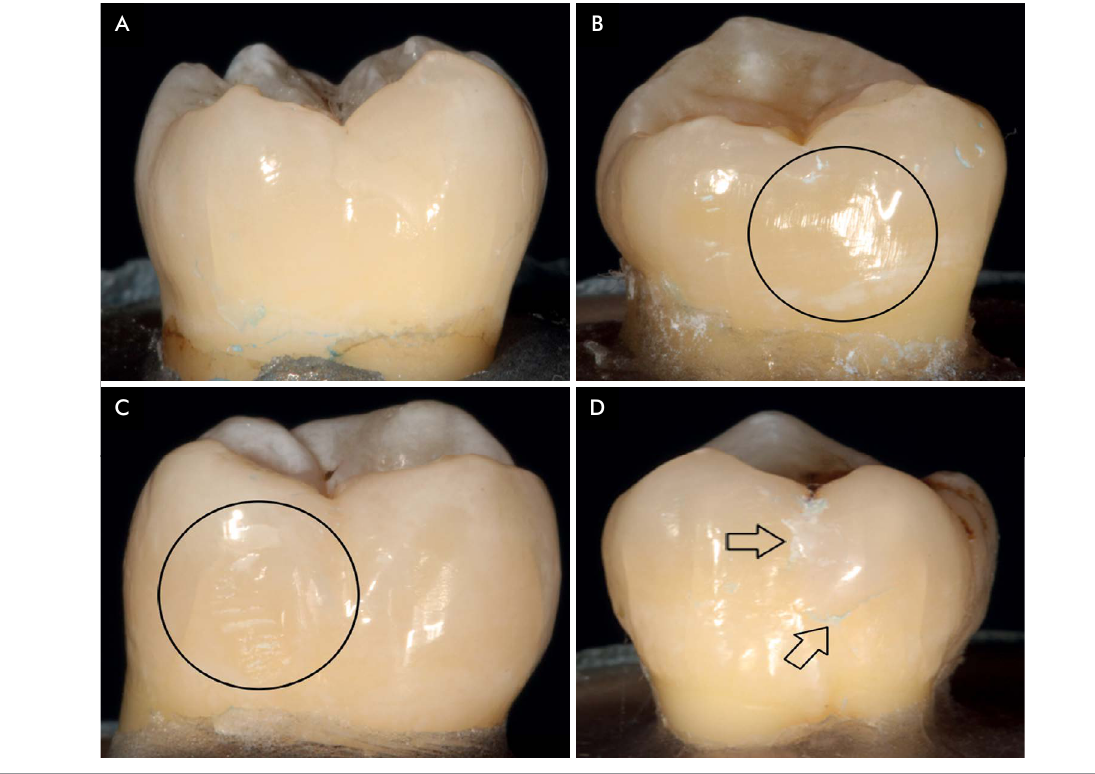
Figure 2. Criteria for direct visual analysis to evaluate the appearance of enamel after removing adhesive remnants: a) intact dental enamel, absence of removal marks; b) dental enamel with the presence of soft removal marks; c) dental enamel with more evident removal marks; d) dental enamel with the presence of adhesive remnants after removal (